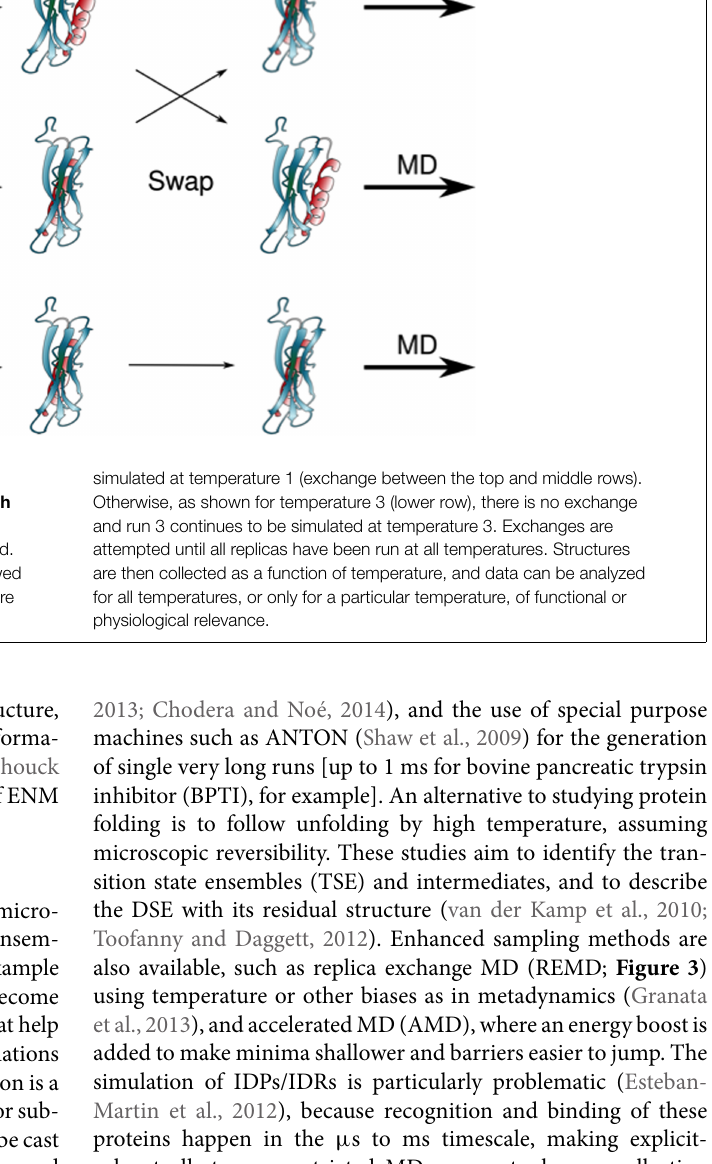
simulated at temperature 1 (exchange between the top and middle rows). Otherwise, as shown for temperature 3 (lower row), there is no exchange and run 3 continues to be simulated at temperature 3. Exchanges are attempted until all replicas have been run at all temperatures. Structures are then collected as a function of temperature, and data can be analyzed for all temperatures, or only for a particular temperature, of functional or physiological